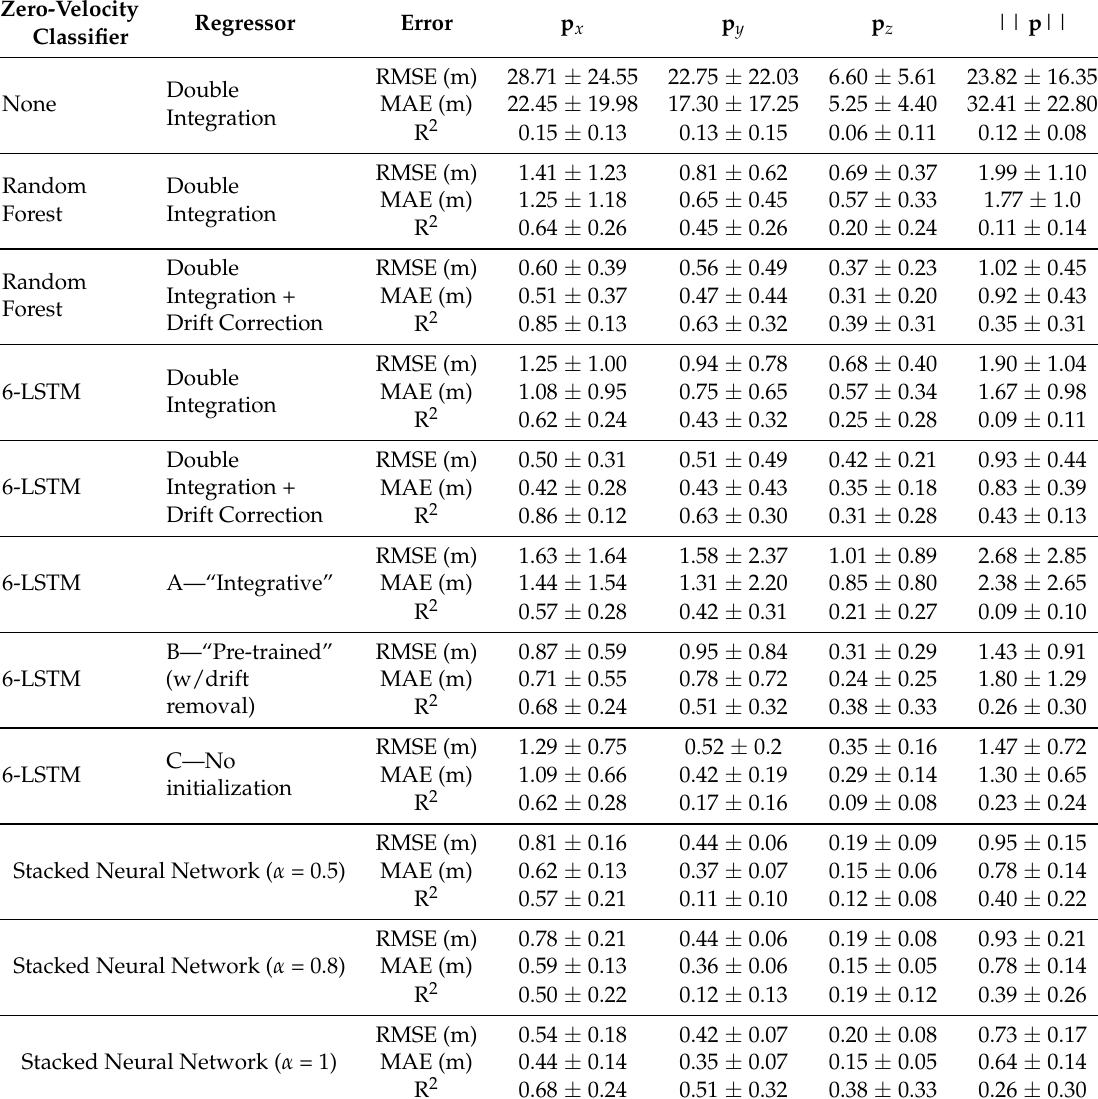
Table 2. MAE, RMSE, and R 2 of the displacement estimate in each axis of the full trial 3D displacement estimate using the different classification and regression